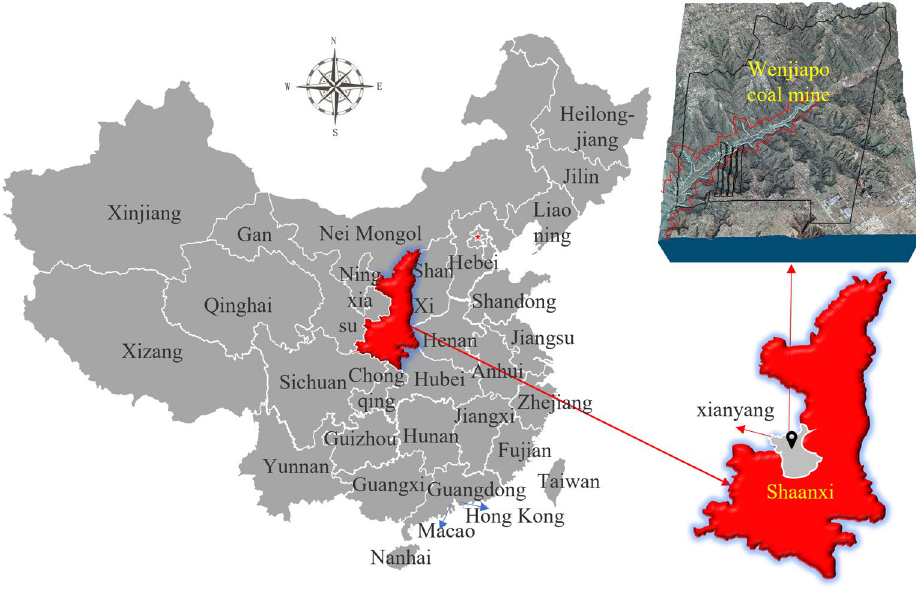
Figure 1. Study area location (China administrative division data from geospatial data cloud: https:// www. gsclo ud. cn/ sourc es/ index? pid= 3& rootid=3, mapping with ArcGIS 10.2